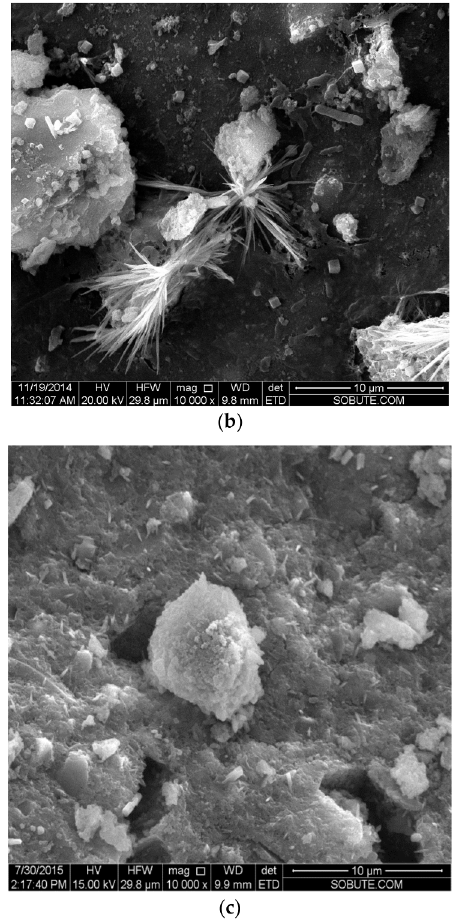
Figure 18. SEM pattern of the geopolymer coating at the age of 28 days. ( a ) M0.8; ( b ) M1.0; ( c ) M1.5. Compared with an SiO 2 /Na 2 O ratio of 0.8 and 1.5, needle-shaped products prepared was observed for an SiO 2 /Na 2 O ratio of 1.0 (see Figure 18b). The needle product could be a crystallite phase of zeolite according to the model reported by Provis et al. [19,20]. As for the geopolymerization, gel phase undergoes a continuous rearrangement and becomes more crosslinked with a release of unbound water. Besides, some zeolitic crystallites are also formed in the geopolymerization. Figure 19 displayed the pattern of Energy Dispersive X-ray Analysis for the needle product. It was observed that the main elements are composed of Silica, Aluminum, Oxygen and Sodium, which supports the suggestion that the needle product could be zeolite crystallite.